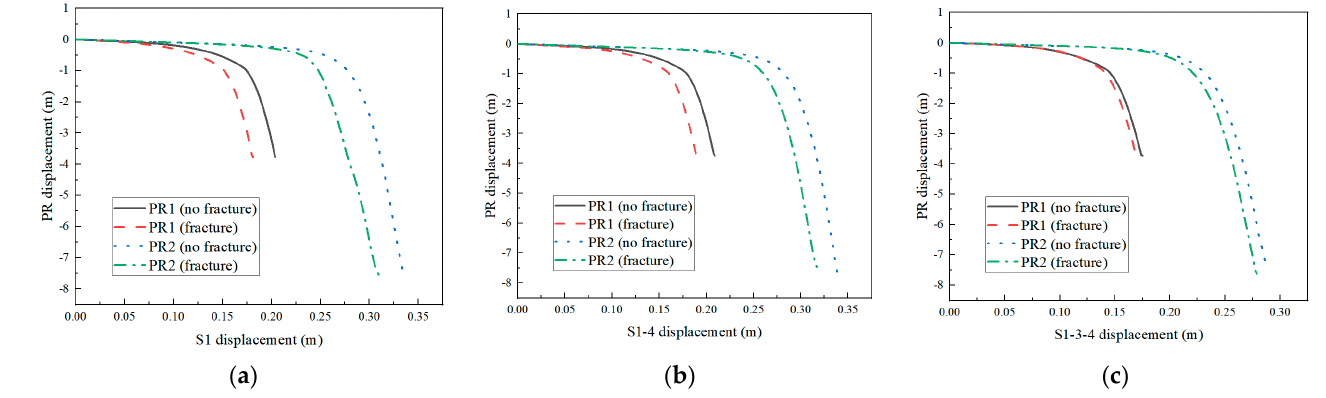
Figure 15. Vertical displacement of RP1 and RP2 with different moving supports: ( a ) Case 1 and 1 ′ ; ( b ) Case 7 and 7 ′ ; ( c ) Case 13 and 13 ′ .